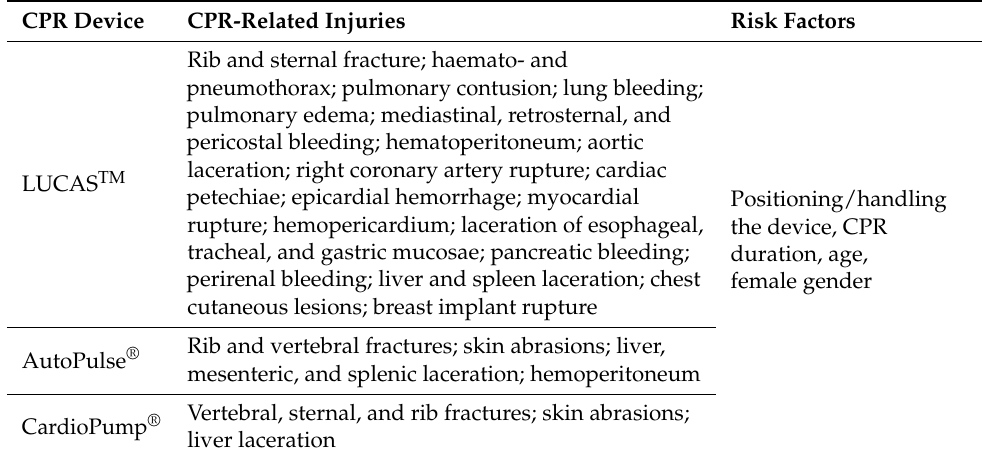
Table 1. CPR-related injuries and risk factors associated with CPR